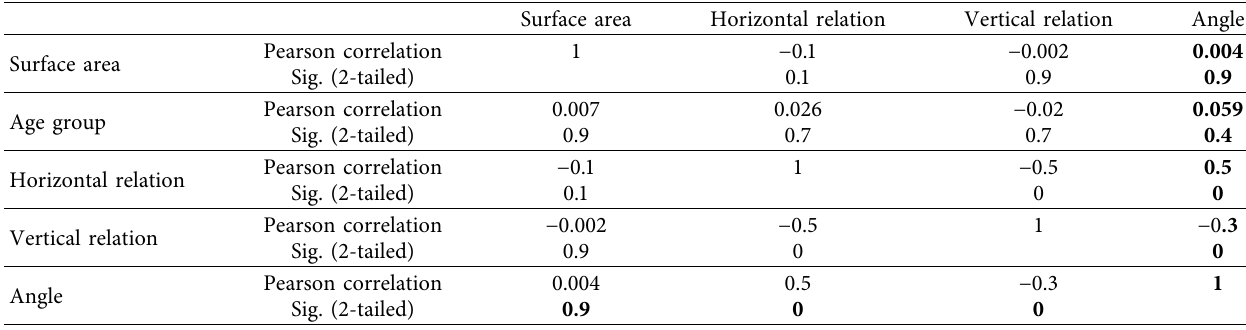
Table 3: Correlation of